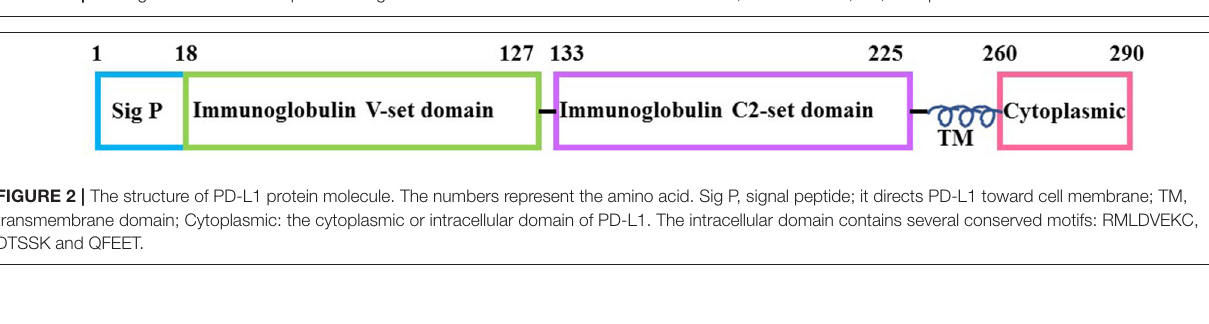
FIGURE 1 | The regulation of PD-L1 expression in glioma cells. Red line indicates RNAs. PTEN-mu, PTEN-mutant; ER, endoplasmic reticulum.